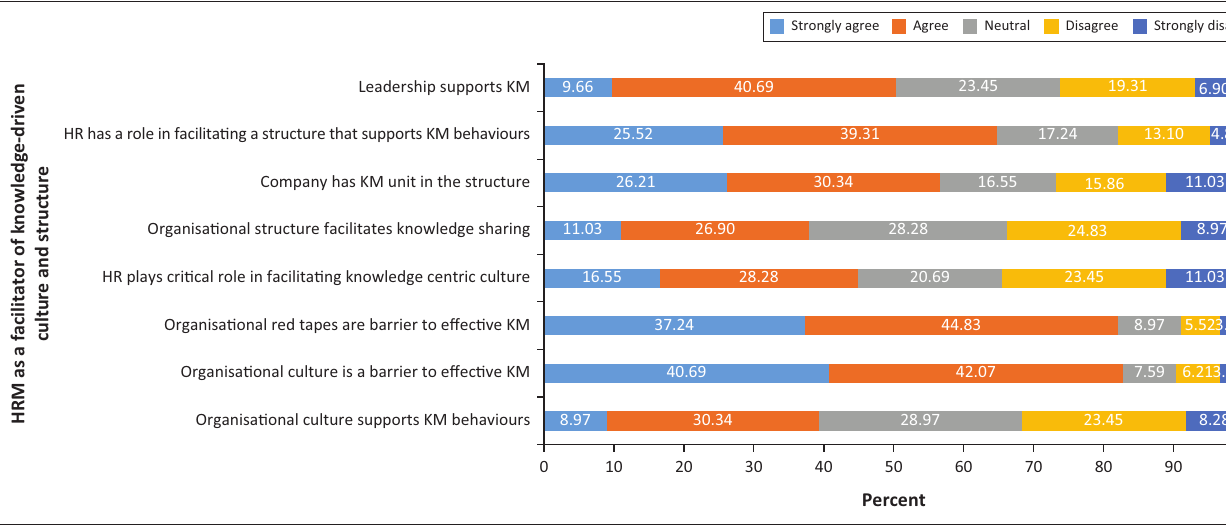
FIGURE 1: Organisational culture and structure support of knowledge